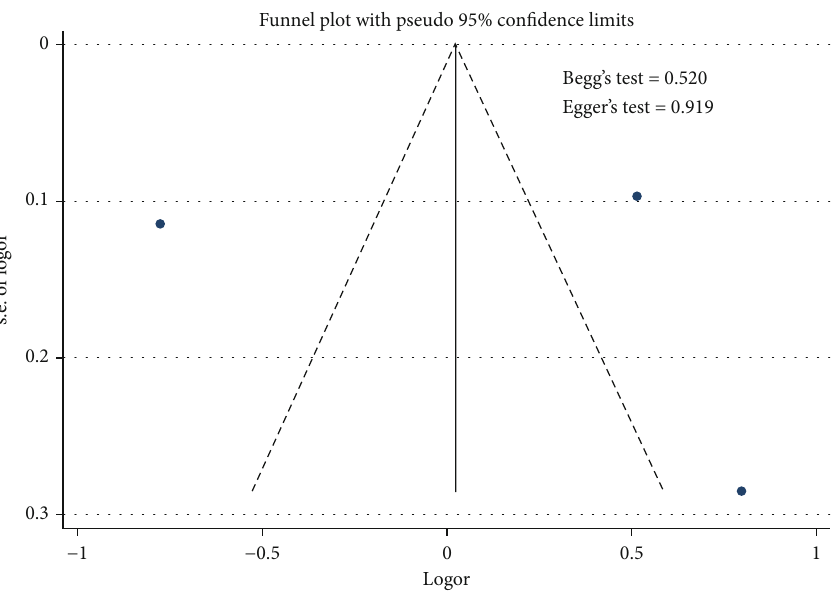
Figure 15: Funnel plots role of age on the uncontrolled